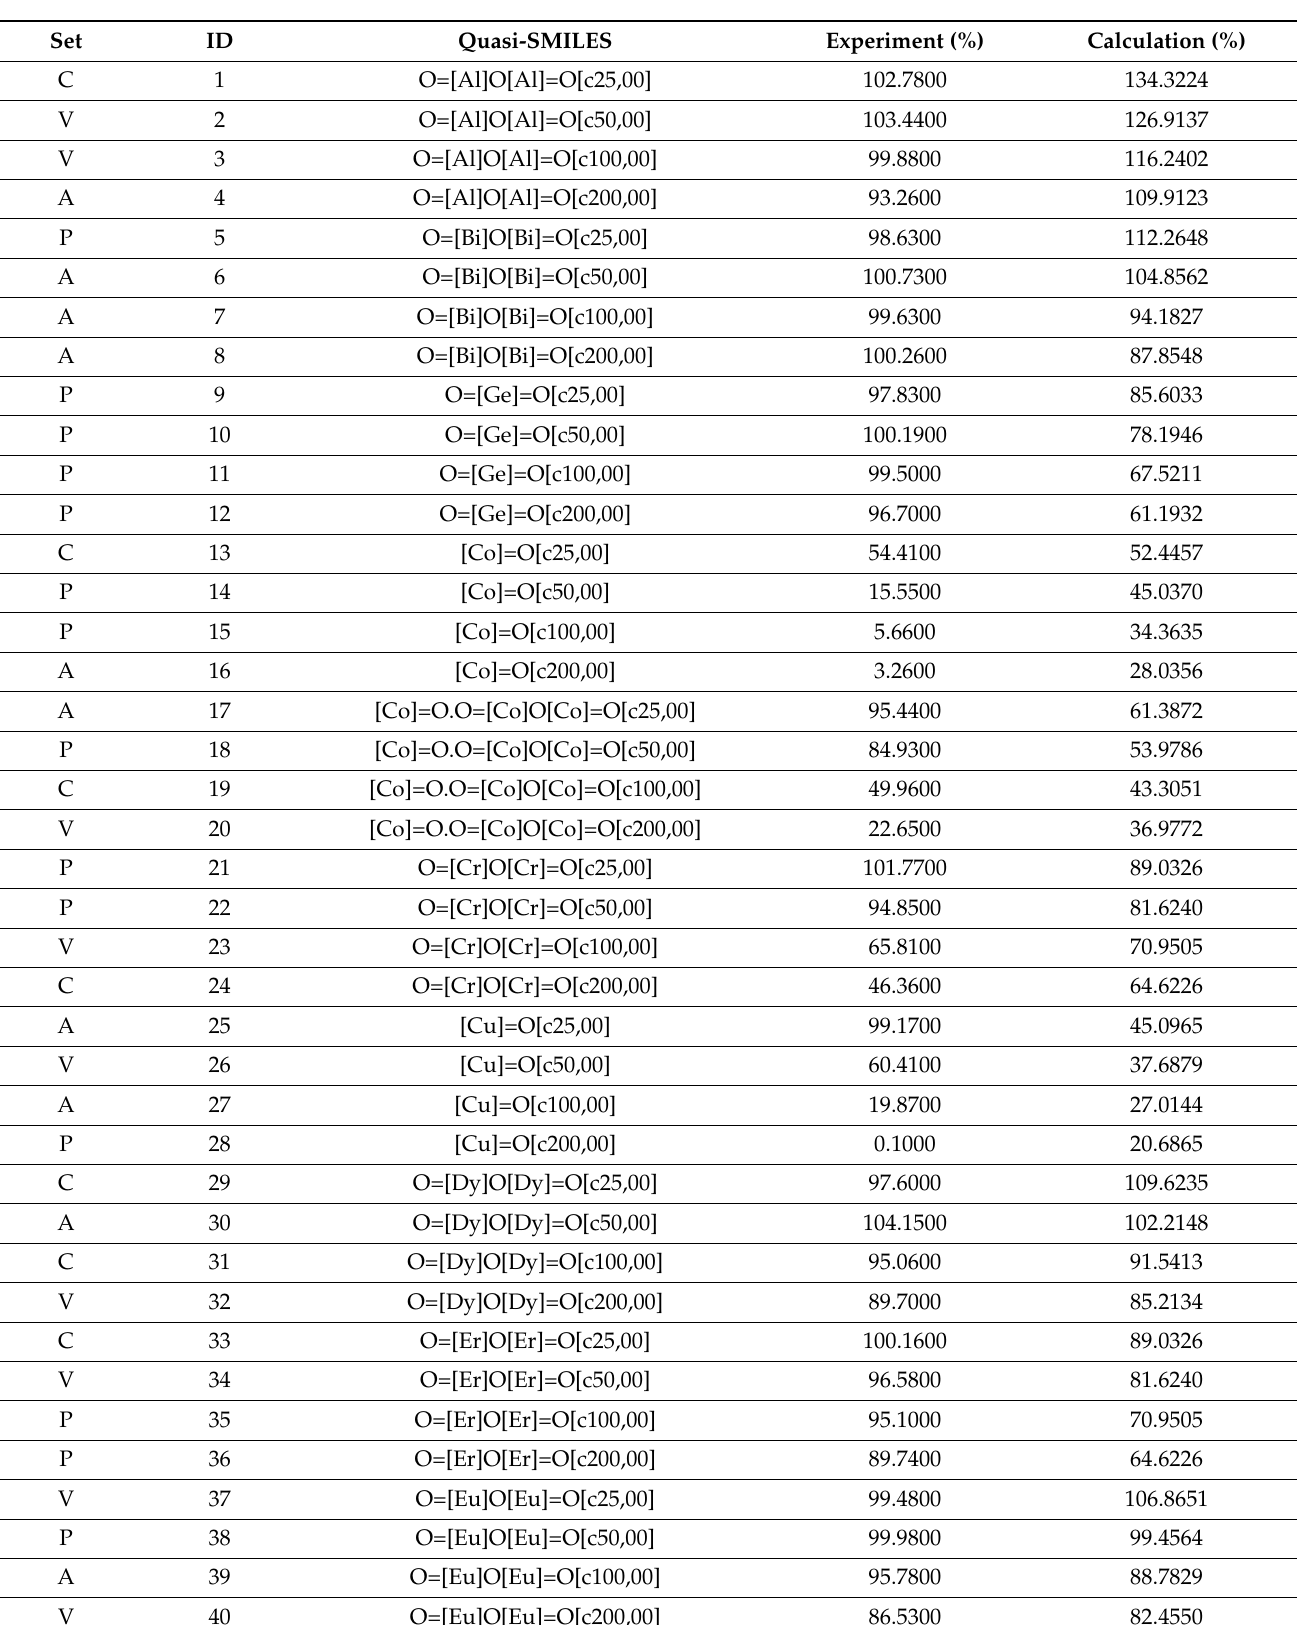
Table 3. The list of quasi-SMILES, experimental and calculated percentage of cell viability in